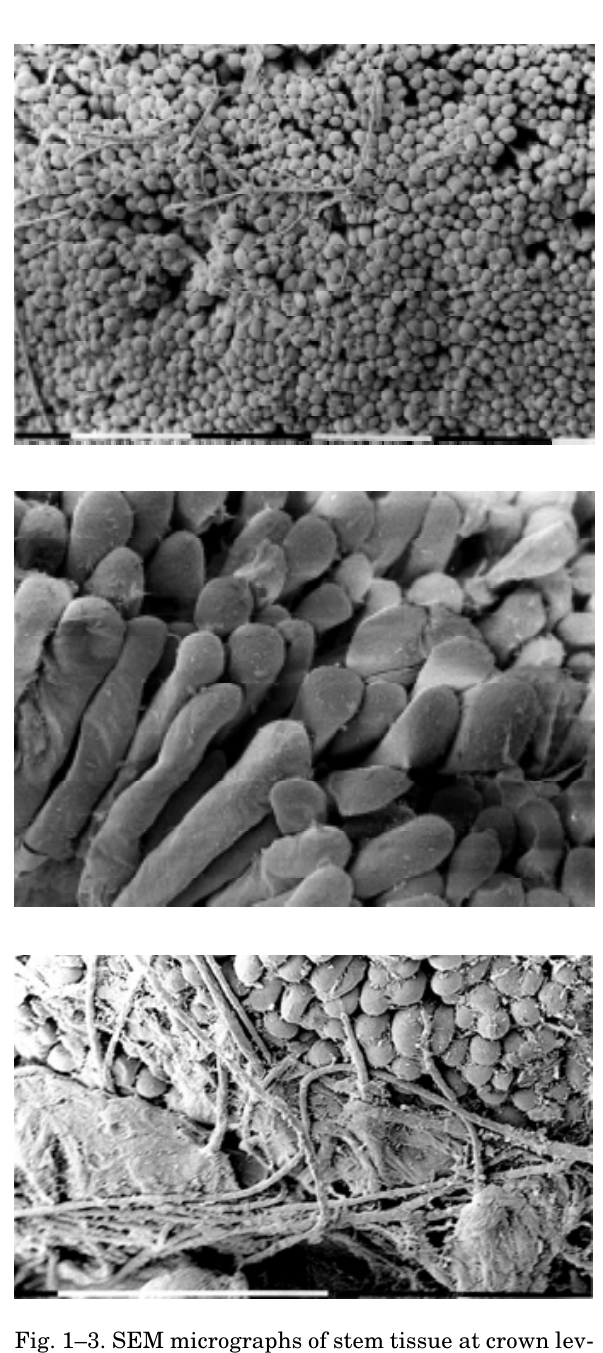
Fig. 1–3. SEM micrographs of stem tissue at crown lev- el of wheat plants at decimal growth stage (GS) 13 grown in Fusarium culmorum -infected soil. Fig. 1. Completely exposed parenchyma showing high cell proliferation. Fig. 2. High magnification of loosely arranged parenchymatic cells with wide spaces in between. Fig. 3. Damaged pa- renchymatic tissue colonised by F. culmorum hyphae (bar=0.1